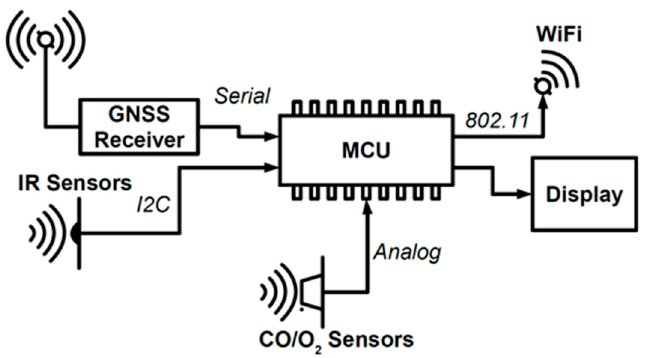
Figure 3. The architecture of the proposed multi ‐ sensor